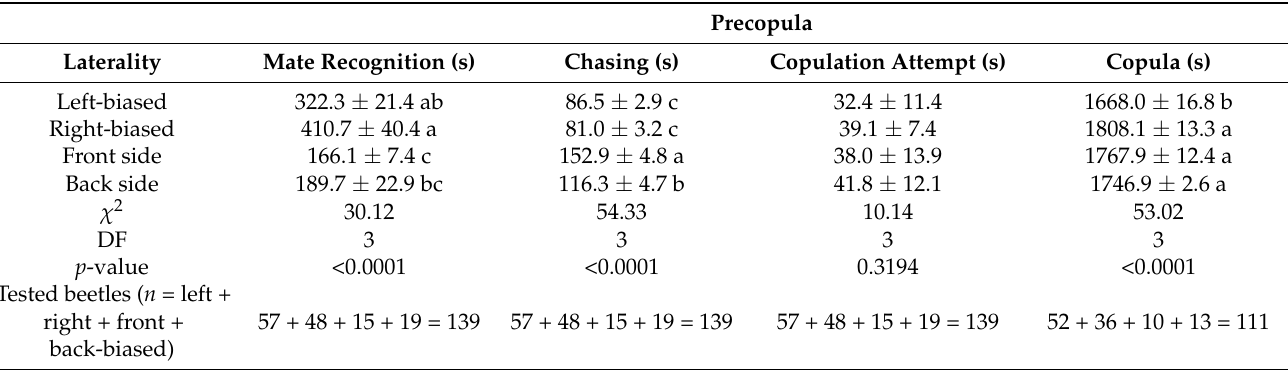
Table 1. Effect of the recognition side bias on the duration of Cryptolestes ferrugineus main mating traits. Values are means followed by standard errors (SE). Within each column, means followed by different letters are significantly different (Steel–Dwass test, p < 0.05). Where no letters exist, differences are not significant among side-biased parameters.